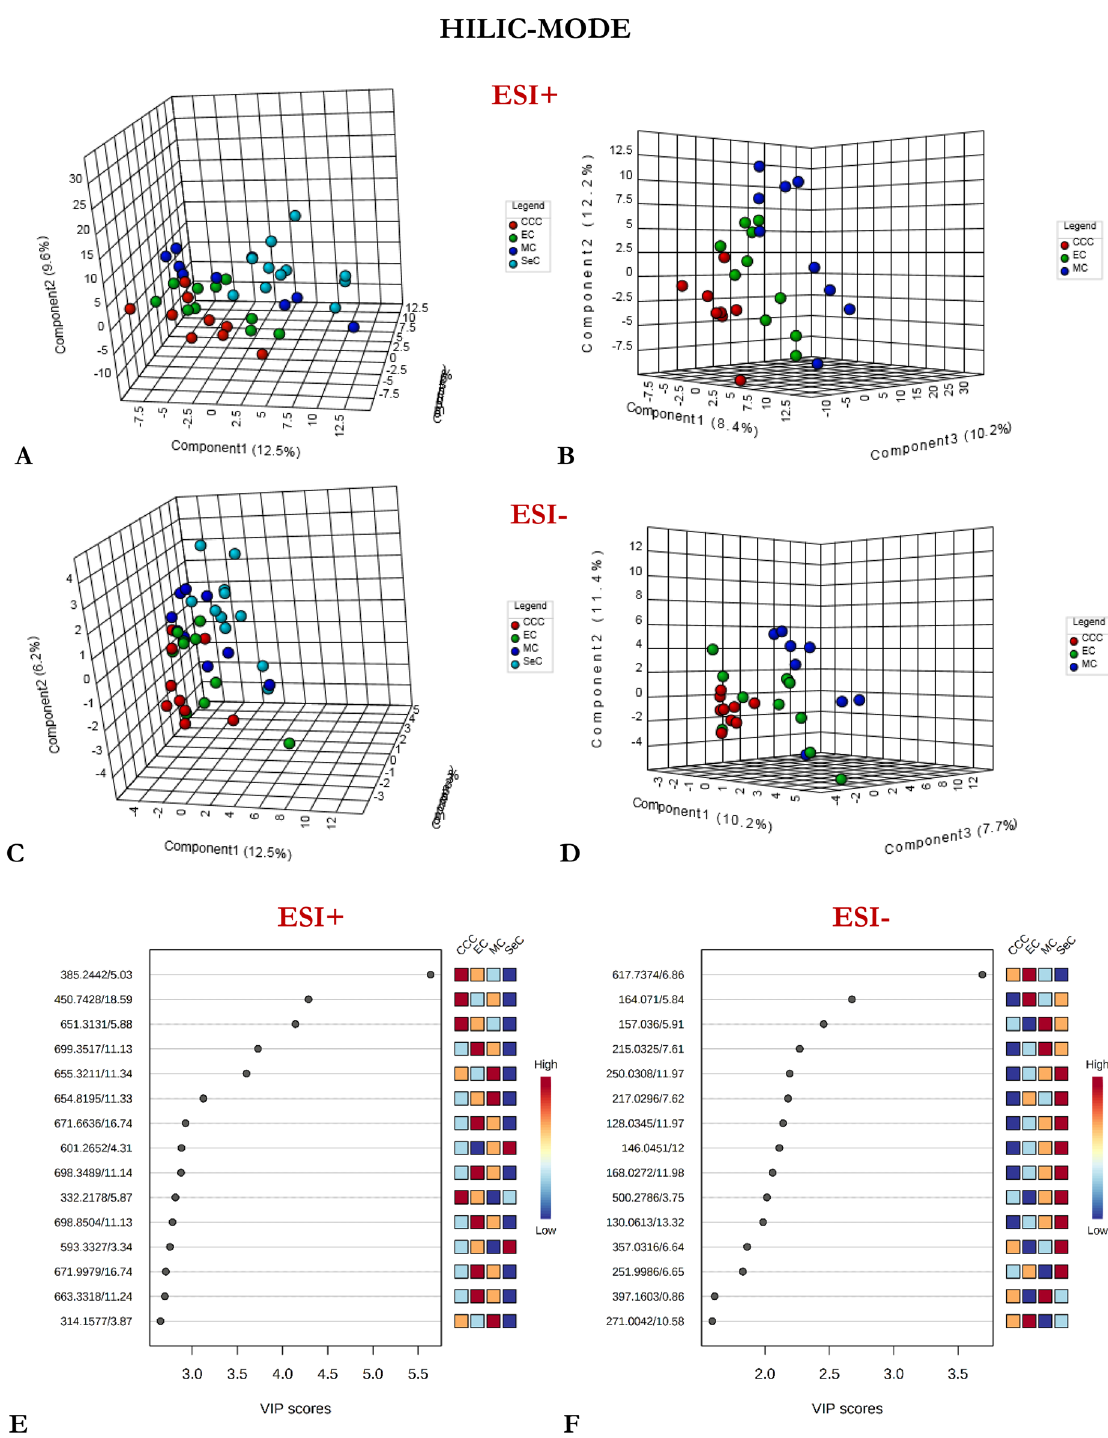
Figure 3. Three-dimensional PLS-DA score plots for features detected in positive ( A , B ) and negative ( C , D ) ion/ HILIC mode and their corresponding VIP values ( E , F ). Red: patients affected by clear cell carcinoma. Green: endometrioid carcinoma patients. Dark blue: mucinous carcinoma patients. Light blue: ovarian serous carcinoma patients. The following data-filtering parameters were used during analysis: RSD of QC samples < 30%; average of pooled QC samples over blanks ratios > 5; total number of features for analysis = 540 (ESI+) and 147 (ESI-). For data collected with HILIC mode, the differentiation in the metabolomic patterns of serous and non-serous OC samples may be observable. VIP schematic scores of PLS-DA analyses for clear cell (CCC) vs endometrioid (EC) vs mucinous (MC) and vs serous (SeC) carcinoma ( E , F ). The labels: component 1, 2 and 3 along the axes (the first three latent variables) represent the scores of the model, which are sufficient to build a satisfactory classification model. The example variables/metabolic features located within a first component and contributing the most to separation between study groups were presented in relevant VIP score plots. ESI+, positive ion mode; ESI-, negative ion